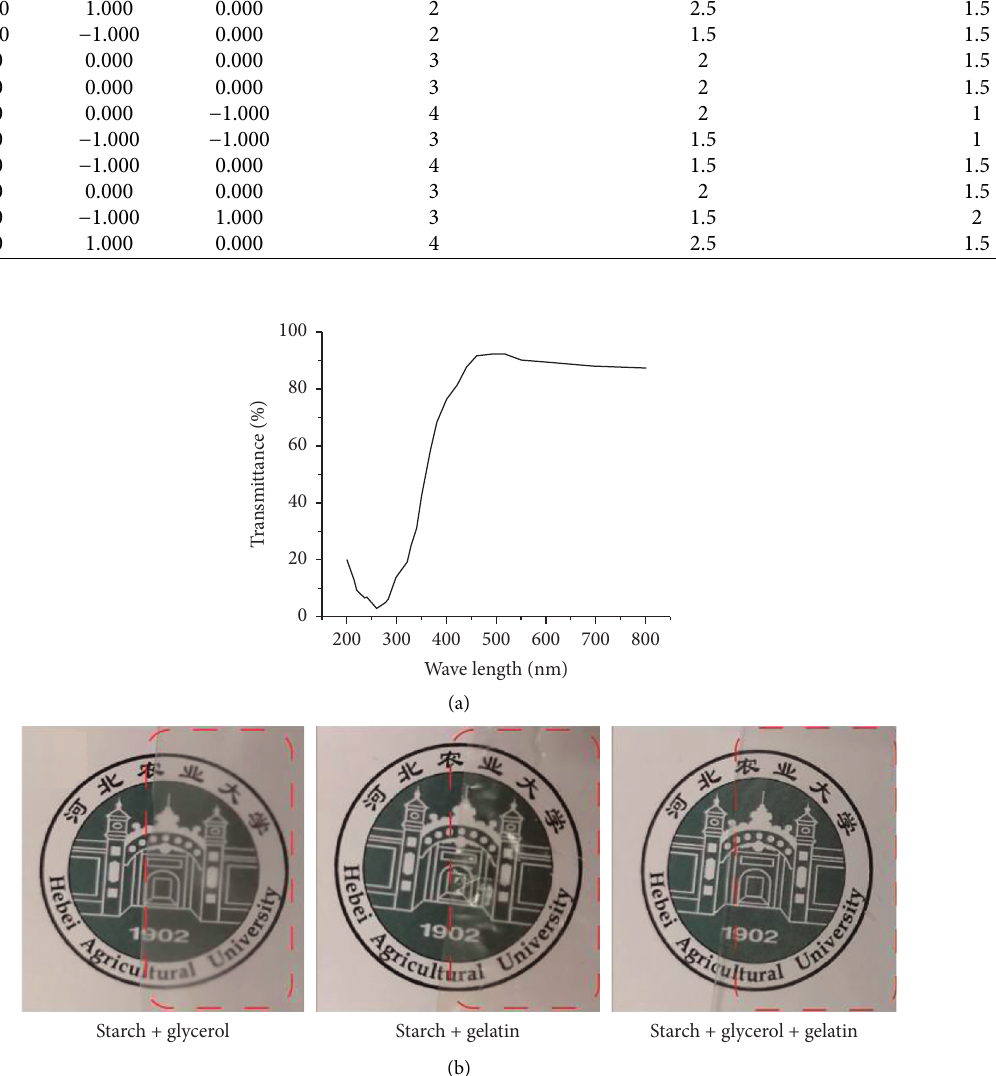
Figure 1: (a) The light transmission curve. (b) The pictures of the